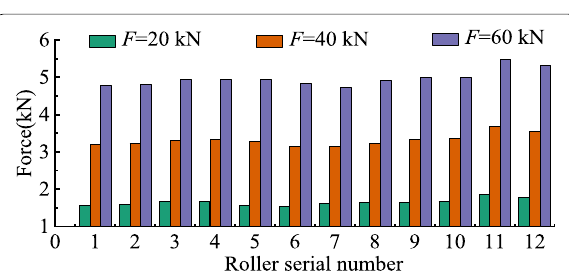
Figure 28 Average contact force of each roller on z axis between screw and